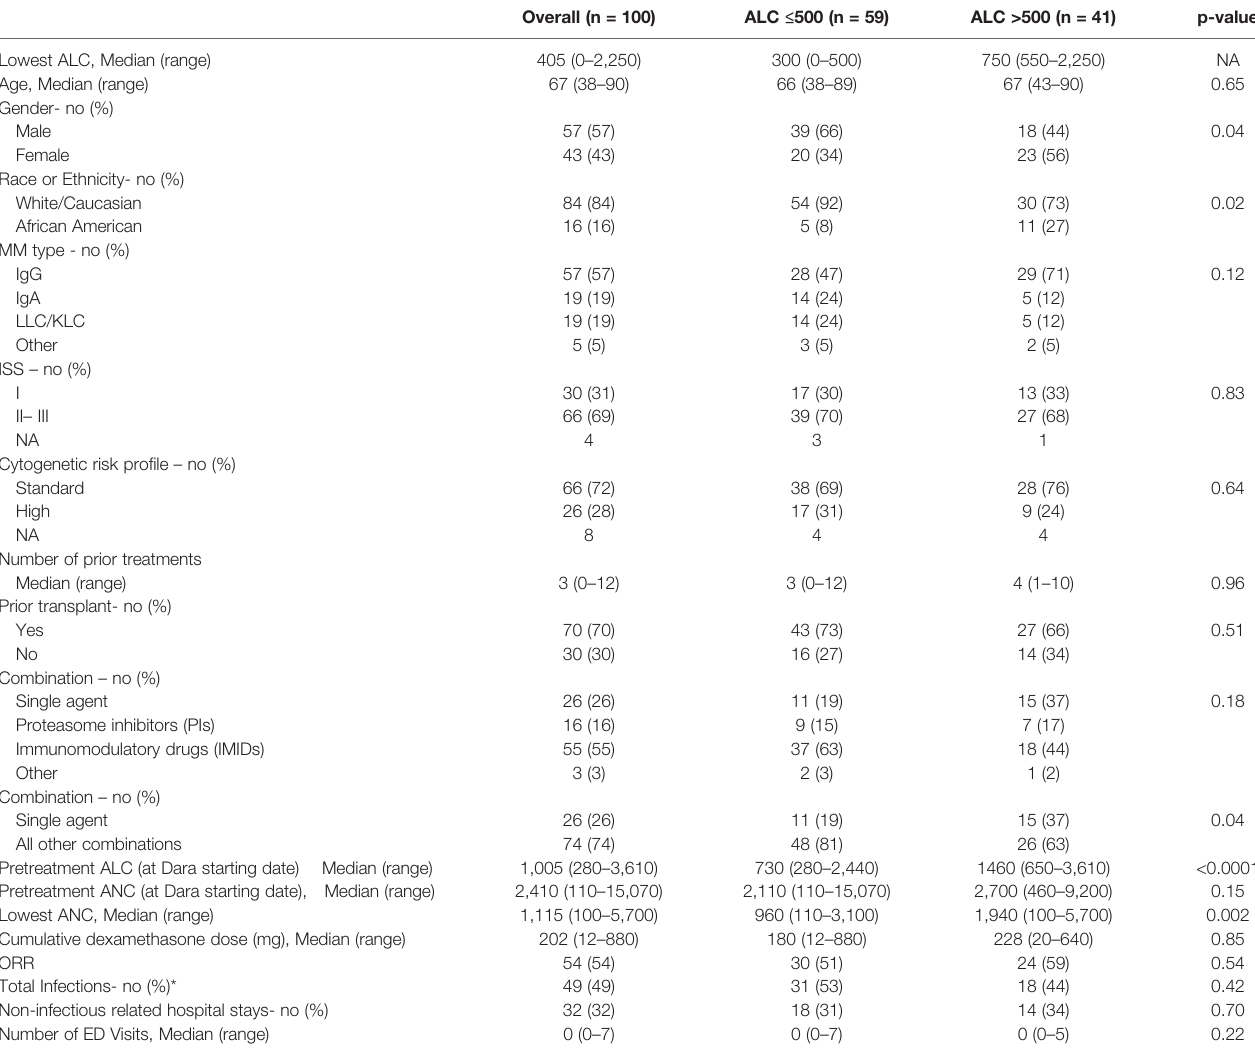
TABLE 1 | Patient demographics, clinical characteristics, and outcomes (n =